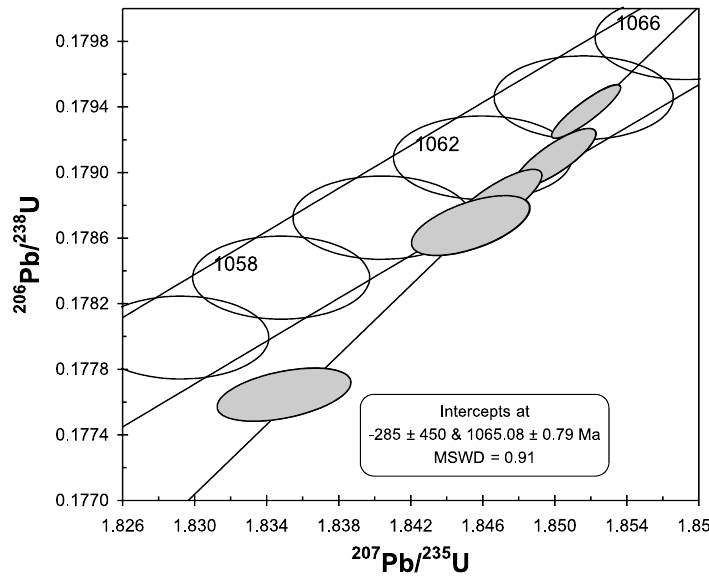
Fig. 1 – The U-Pb concordia diagram for 91500 standard using 235 U- 208 Pb “